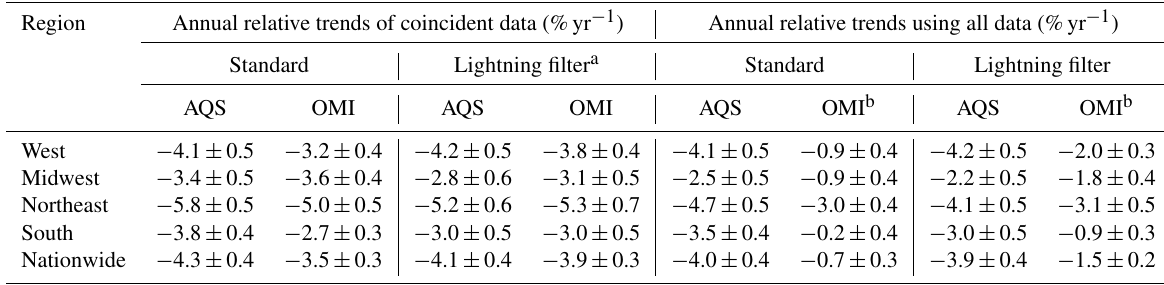
Table 1. Annual relative trends calculated with coincident data and all available data. The 95th-percentile confidence intervals from Mann– Kendall method are also listed.